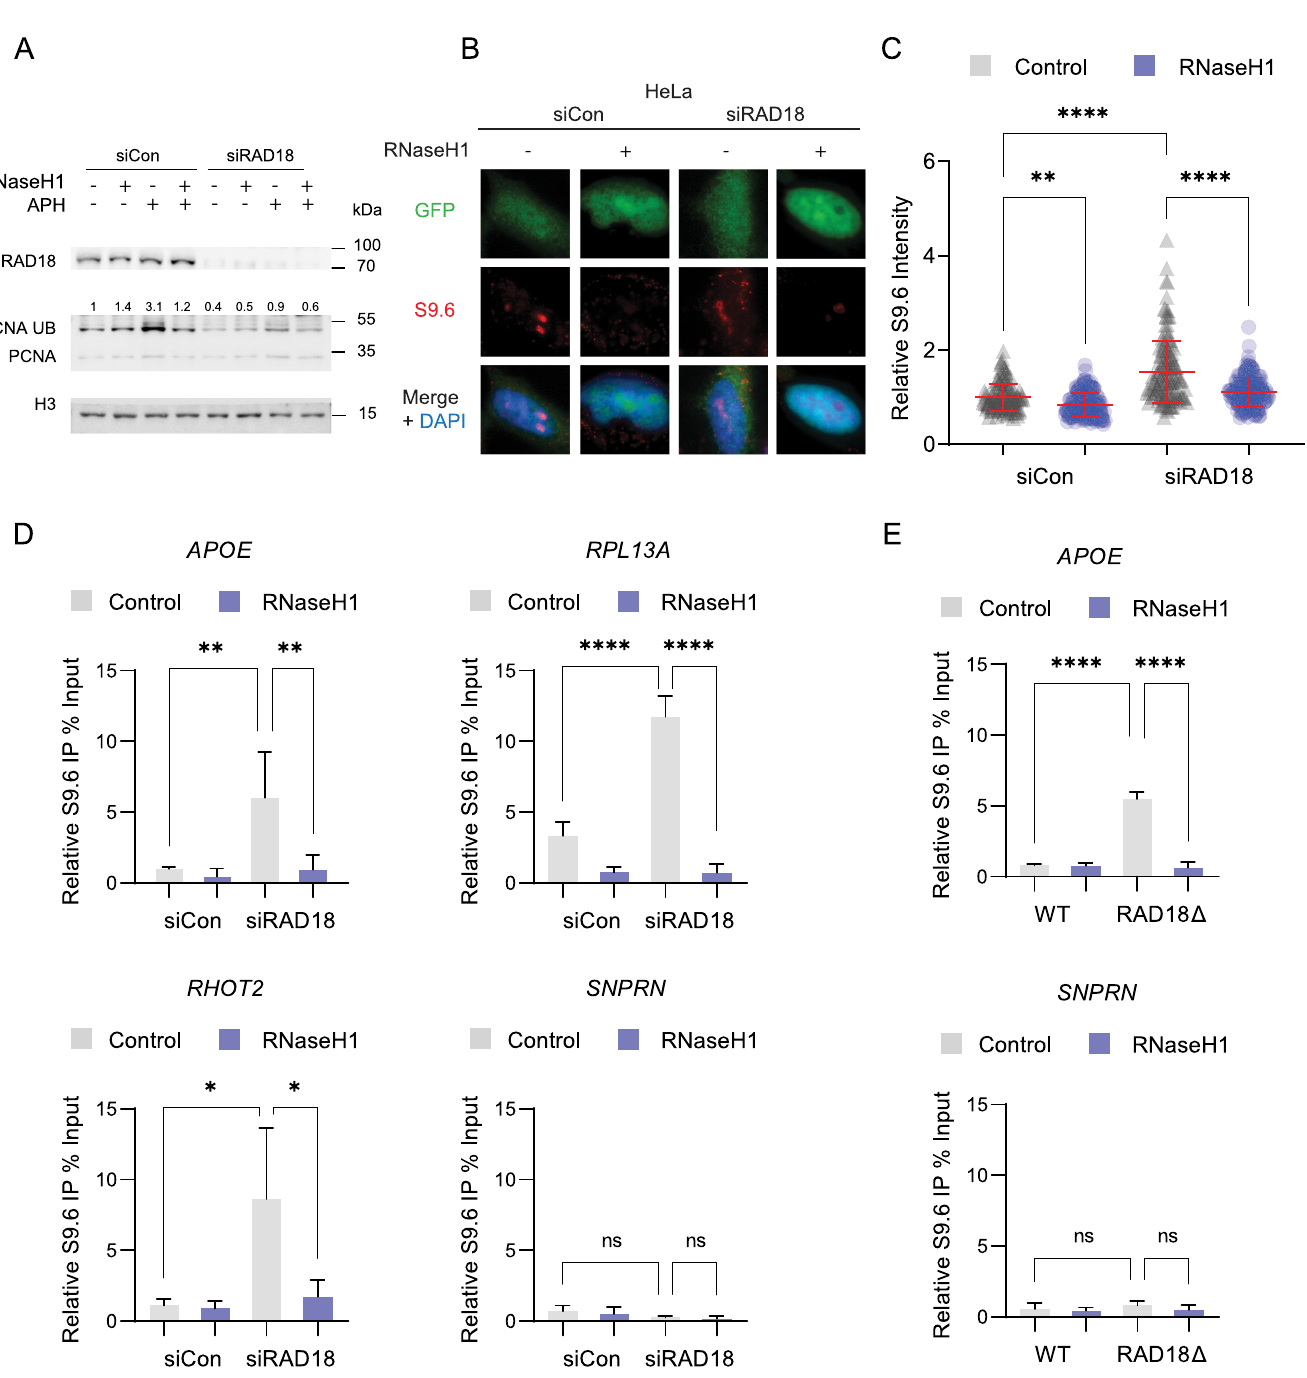
Fig 1. Loss of RAD18 increases DNA:RNA hybrids. (A) Western blot of chromatin bound lysates representing RAD18 knockdown with pooled siRNA and the subsequent reduction of PCNA ubiquitination in HeLa cells. Ubiquitinated PCNA is increased in cells treated with APH for 24 hours, and this is reduced in cells transfected with RnaseH1 expression plasmid. (B,C) Nuclear S9.6 antibody staining in non-targeting control siRNA or siRAD18 treated HeLa cells with or without transfection of GFP-tagged RNaseH1 overexpression plasmid. B, representative images, C, quantification. (D) DRIP-qPCR in non-targeting control siRNA and siRAD18 HeLa cells at R-loop prone sites APOE, RPL13A, RHOT2, and negative control site SNPRN with and without RNaseH1 treatment. (E) DRIP-qPCR in P53 -/- RPE1 WT and RAD18 KO cells at R-loop prone site APOE and negative control site SNPRN. Treatment concentrations of APH (400 nM). ANOVA p < 0.05, N = 3 for all. Error bars represent standard deviation and the central line represents the mean. siCon , non-targeting control siRNA; ns , not significant; � , p < 0.05; �� , p < 0.01; ��� , p < 0.001; ���� , p < 0.0001.